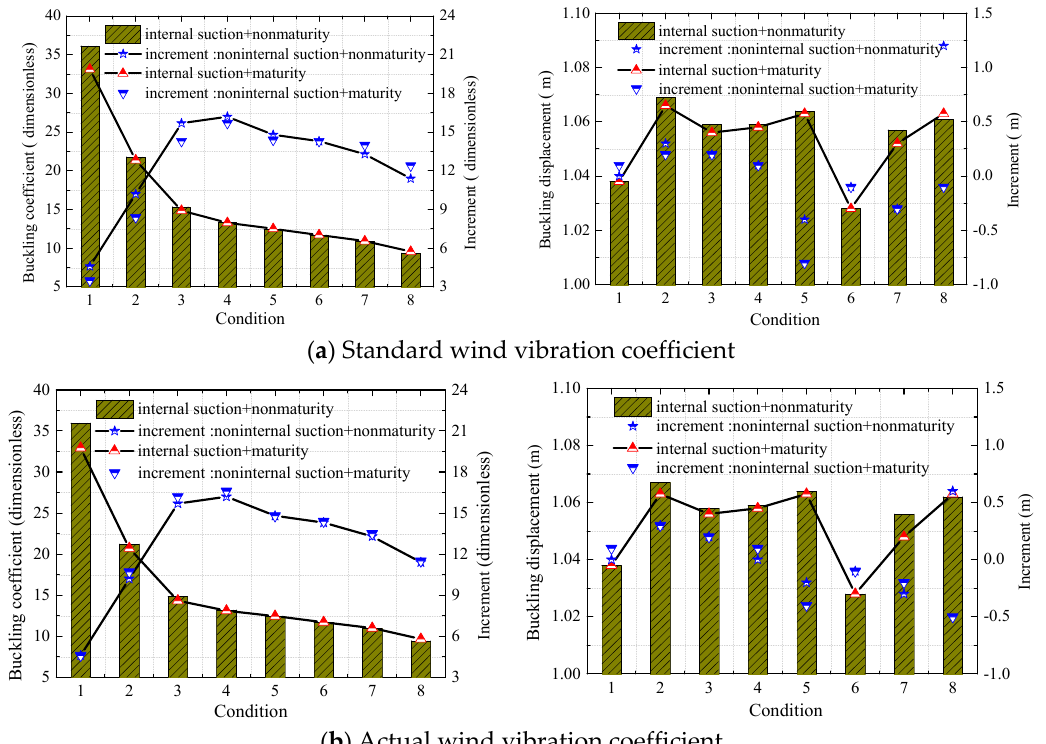
Figure 16. Comparison of buckling coefficient and displacement under standard and actual wind vibration coefficients.